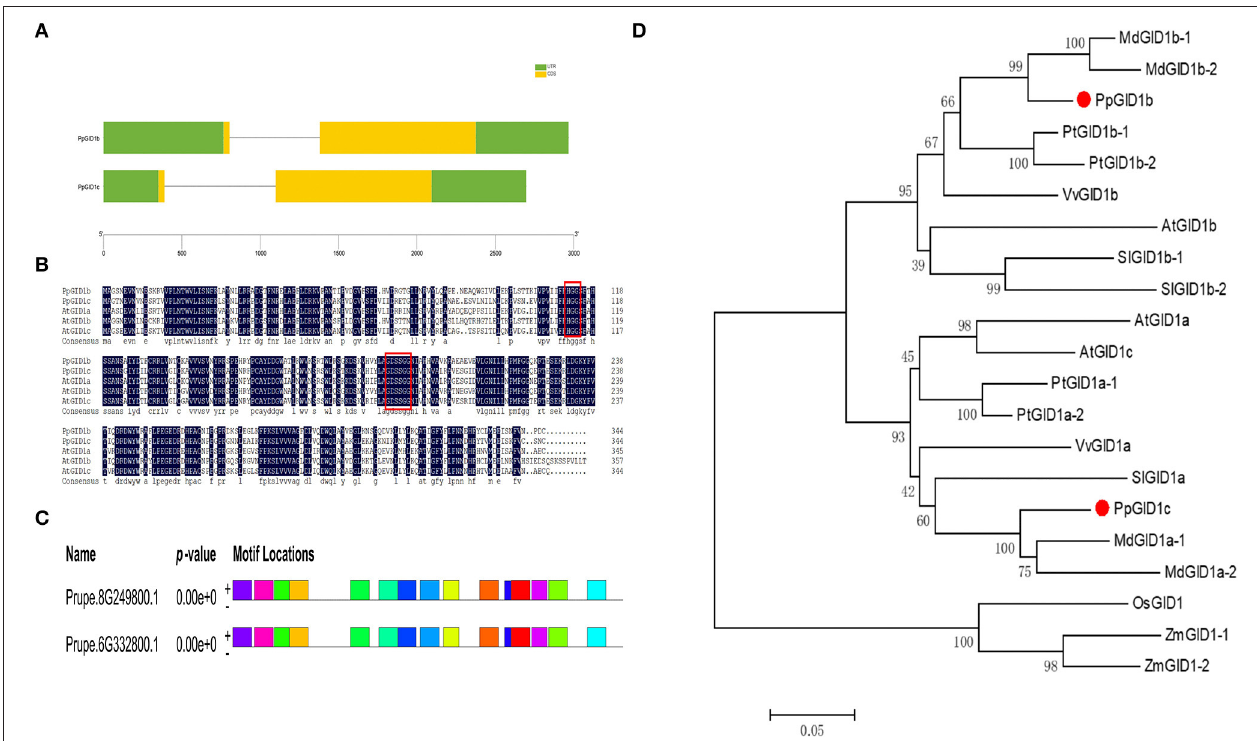
FIGURE 1 | Structure and protein sequence analyses of PpGID1b and PpGID1c. (A) PpGID1b and PpGID1c gene structure. The yellow parts indicate exons, the green parts indicate the CDS sequences, and the lines indicate introns. (B) Alignment of the amino acid sequences of PpGID1b and PpGID1c with AtGID1a, AtGID1b, and AtGID1c. The red boxes are marked with HGG and GDSSG domains. (C) Analysis of PpGID1 conserved elements. (D) Phylogenetic tree of gibberellin insensitive dwarf1 (GID1) proteins from different species. Prunus persica : Prupe.8G249800 (PpGID1b), Prupe.6G332800 (PpGID1c). Populus trichocarpa : Potri.005G040600 (PtGID1a-1), Potri.013G028700-(PtGID1a-2), Potri.002G213100 (PtGID1b-1), Potri.014G135900 (PtGID1b-2). Vitis vinifera : GSVIVG01022014001 (VvGID1a), GSVIVG01011037001 (VvGID1b). Arabidopsis thaliana : AT3G05120 (AtGID1a), AT3G63010(AtGID1b), AT5G27320 (AtGID1c). Solanum lycopersicum : Solyc01g098390 (SlGID1a), Solyc06g008870 (SlGID1b-1), Solyc09g074270 (SlGID1b-2). Oryza sativa : LOC_Os05g33730 (OsGID1). Zeamays: GRMZM2G173630_T01 (ZmGID1-1), GRMZM2G016605_T02 (ZmGID1-2). Malusdomestica : MDP0000319301(MdGID1a-1), MDP0000445131